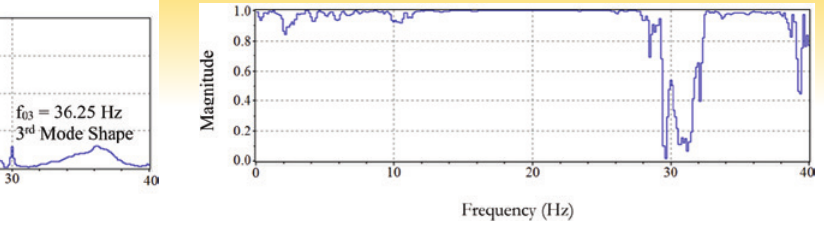
(a) Point 1 (1/4 of the span): FRF